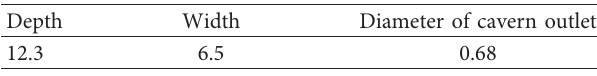
Table 5: Minor prototype geometric parameters of typical small and medium coal and gas outburst (m) ∗ .